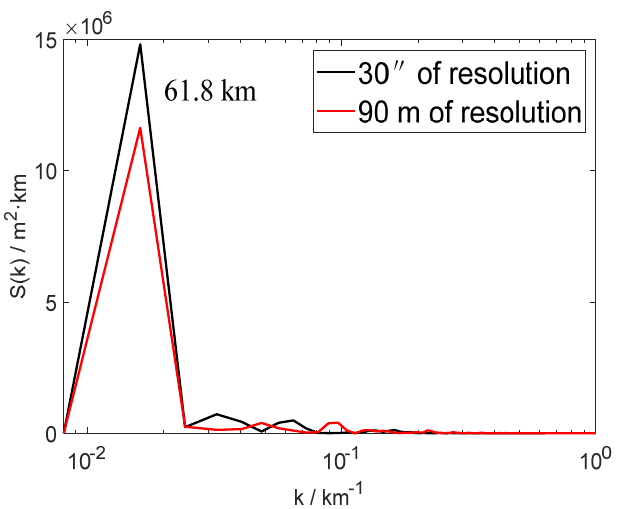
Figure 4. Terrain height variance spectra for the cross section along 31° N. Black curve and red curve correspond to 30 ″ resolution and 90 m resolution, respectively.